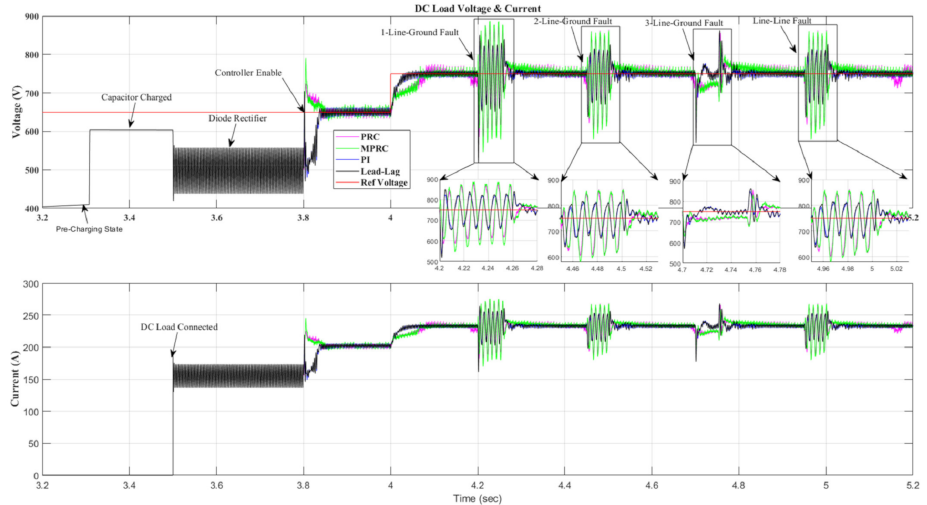
Figure 8. DC voltage and current comparison of PI, lead–lag, PRC, and MPRC controllers at 175